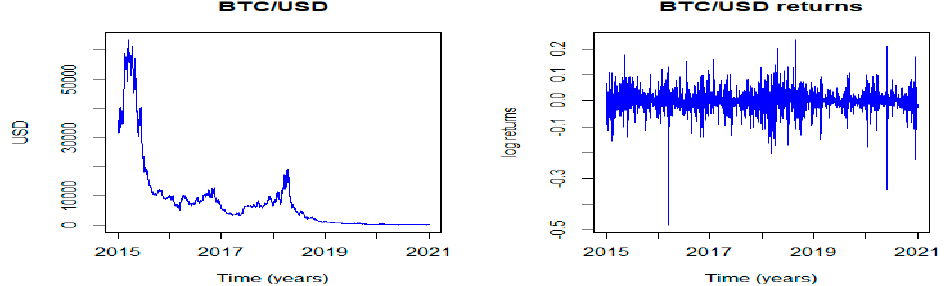
Figure 1. Plot of BTC/USD prices ( left ) and one-day log returns ( right ).